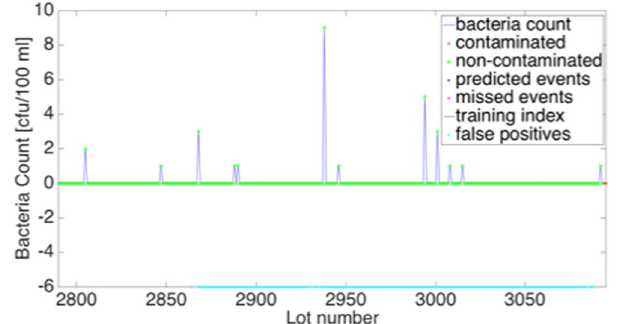
Figure 4. SVM prediction – Snippet from Rosh Hayin 8 time series Oct. 2008–Aug.